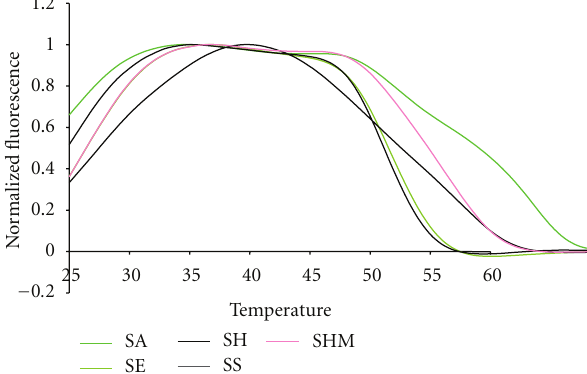
Figure 7: The anneal curve showing the fluorescent contour of the control L. lactis in the Cal Orange